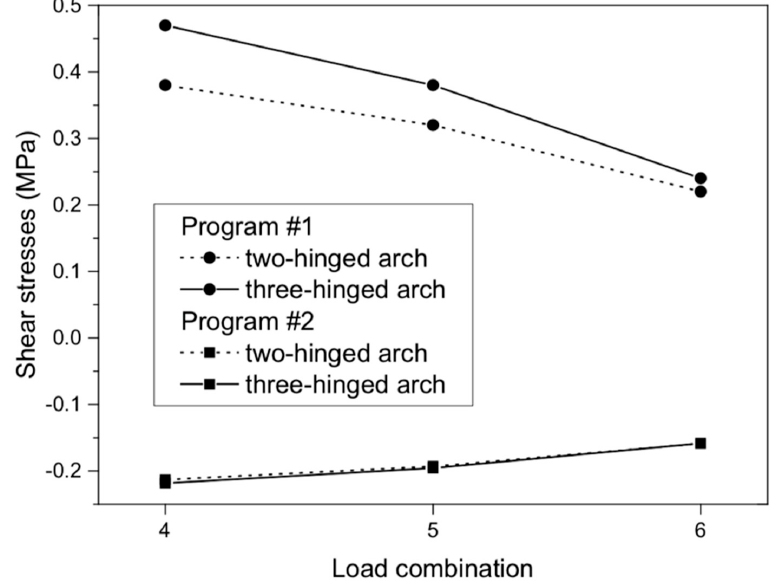
Figure 14. Shear stresses of masonry arch for load combinations.